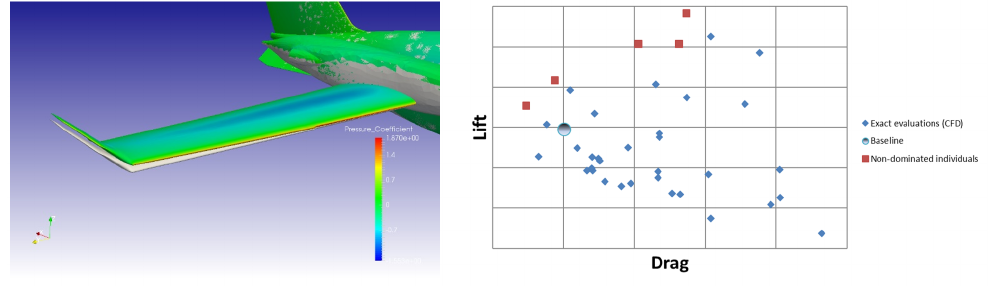
Figure 14. Deformed and not deformed configurations. Right: design space main results